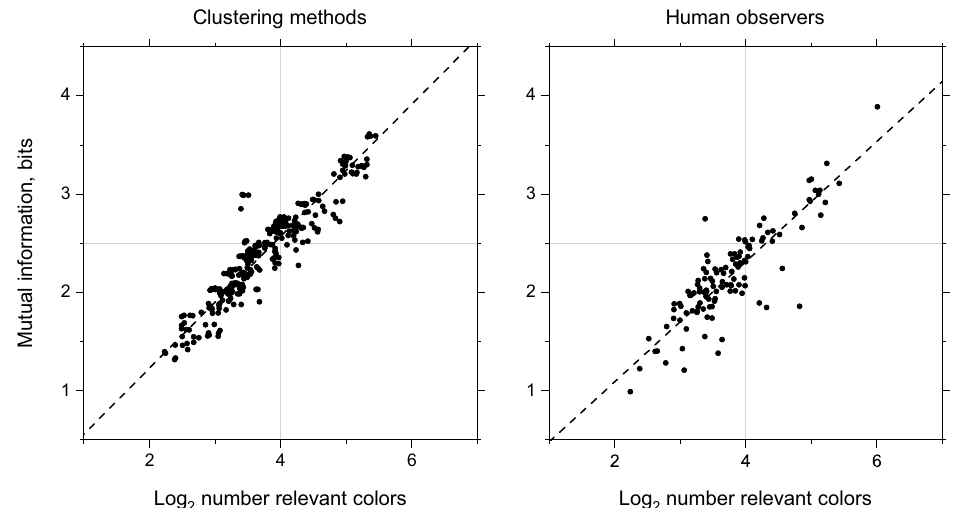
Figure 3. Information and number of relevant colors. Estimated mutual information is plotted against logarithm to the base 2 of the number of relevant colors n for the five clustering methods and six human observers. Horizontal jitter has been added to reduce overlap between symbols 35 . The dashed lines represent linear regressions on the unjittered data.